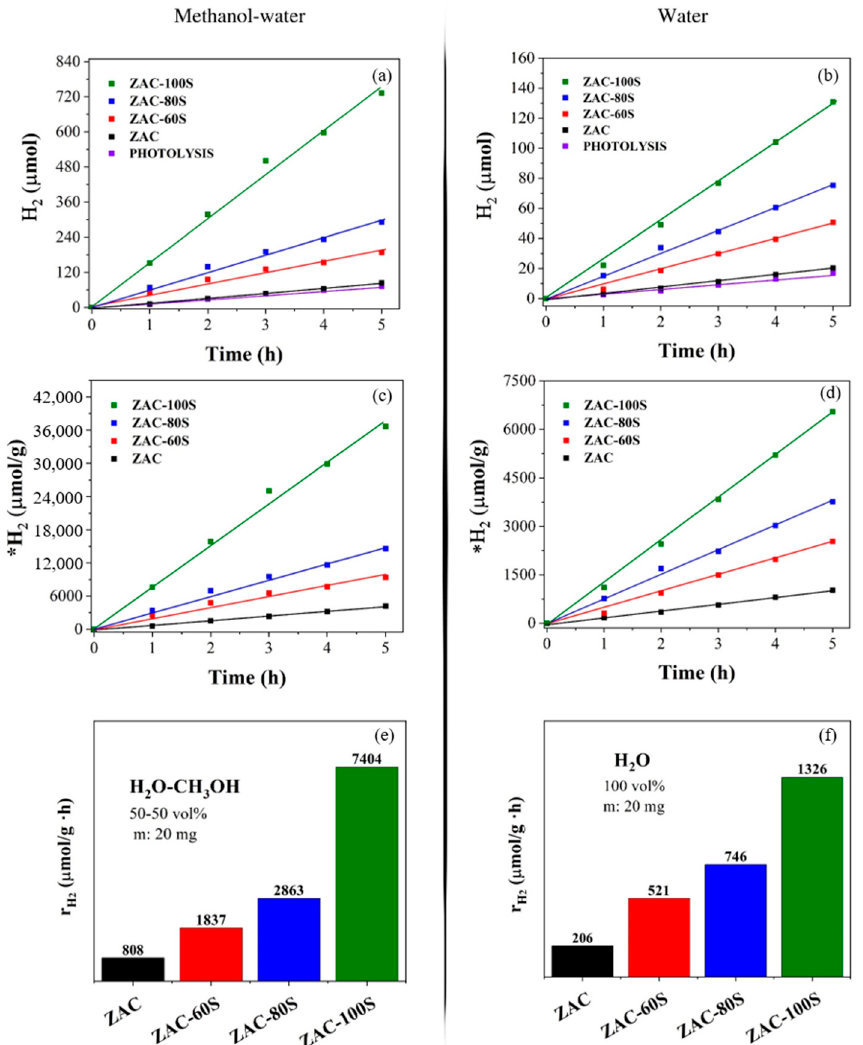
Figure 10. ( a , c , e ) Results in a methanol-water solution (50-50 vol%); ( b , d , f ) results without sacrificial reagent; ( a , b ) hydrogen production over the time (H 2 , µmol); ( c , d ) hydrogen produced per gram of photocatalyst (*H 2 ); and ( e , f ) reached rate constants in the hydrogen production (r H2 ).